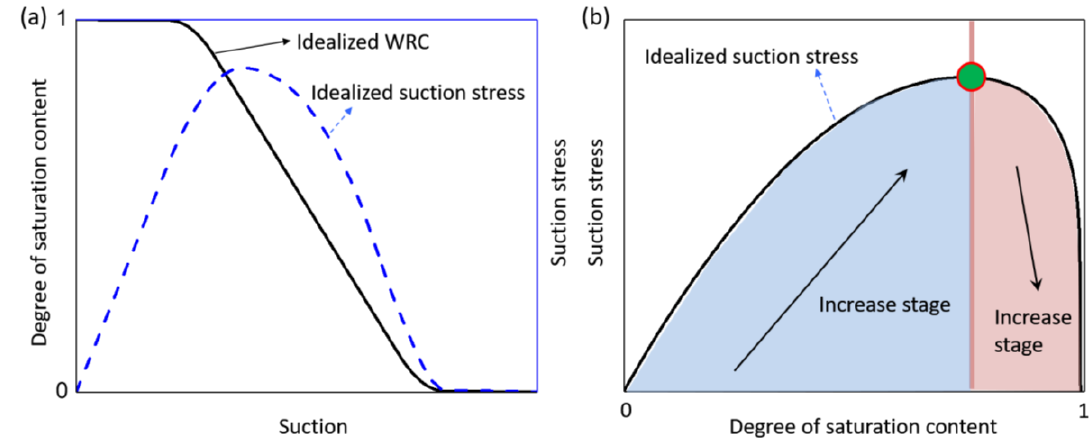
Figure 8. Idealized water retention curve (WRC) and suction stress. ( a ) Relationships between saturation and suction, and suction stress and suction; ( b ) Idealized suction stress and degree of saturation content, which is derived from ( a ).